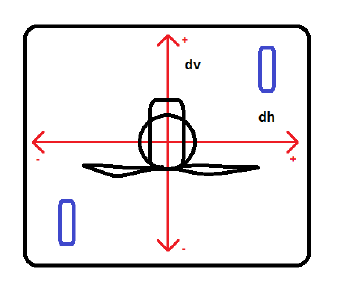
Figure 15. Two TMDs located on the platform with diagonal symmetry.